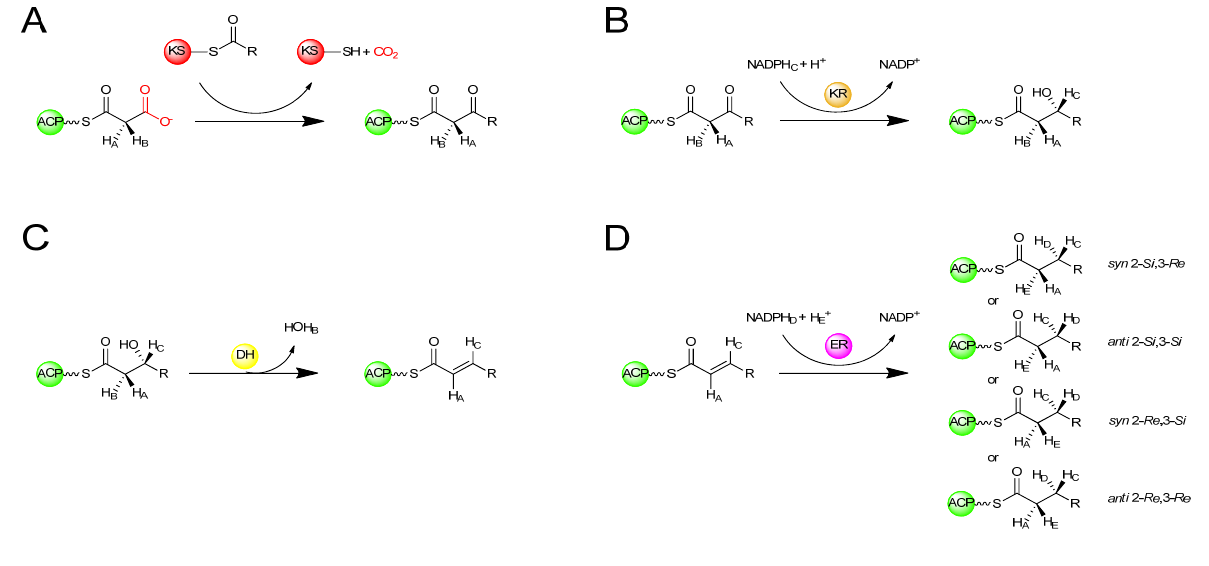
Figure 4. Stereochemical course of reactions during fatty acid biosynthesis [14-21]. ( A ) Stereochemical inversion at C-2 upon KS-catalysed condensation. ( B ) Ketoreduction of the 3-ketone to produce a 3 R -configured β -hydroxyl intermediate. ( C ) Dehydration of the β -hydroxyl intermediate generating a trans -configured double-bond ( D ) Enoylreduction of the unsaturated intermediate in varying organisms by alternative stereochemical